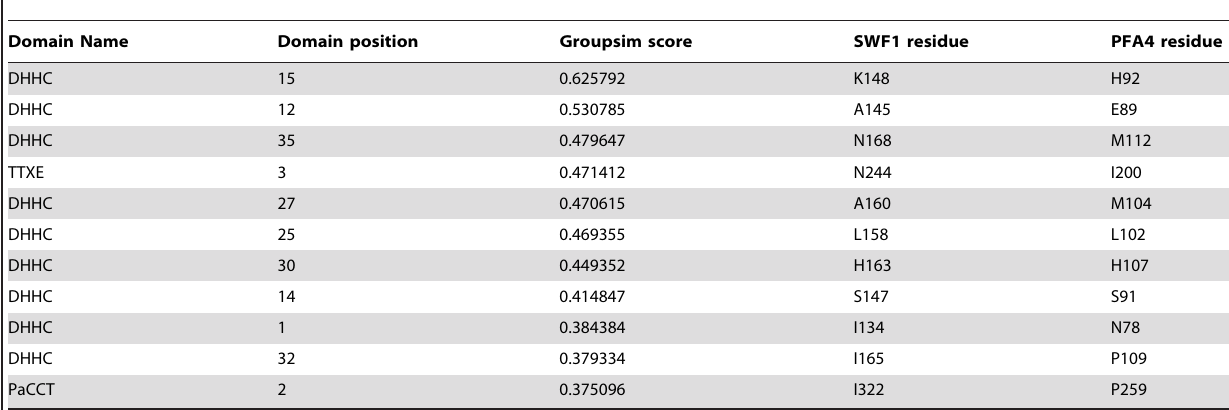
Table 1. Highest scoring specificity determination